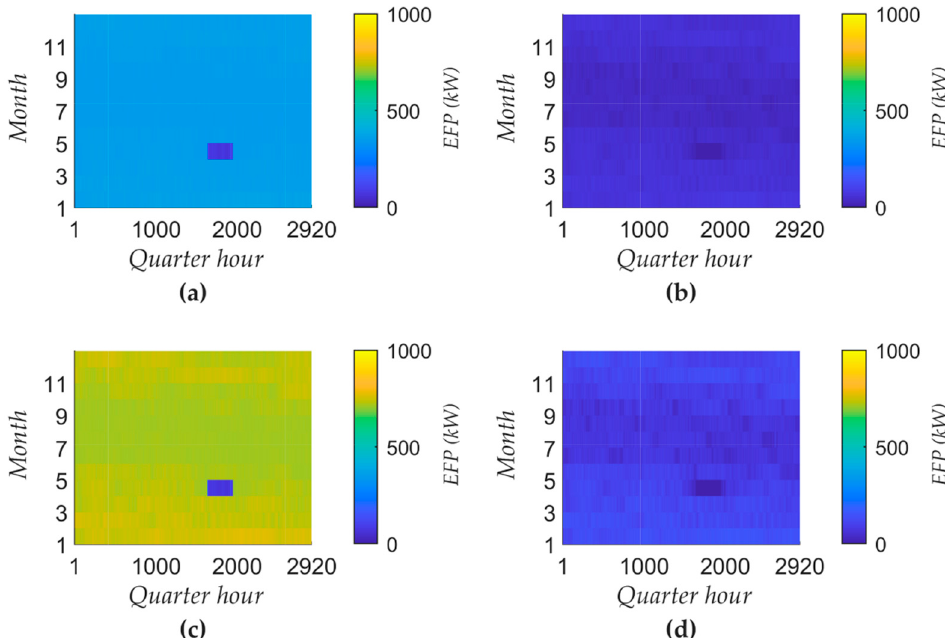
Figure 8. Technical energy-flexibility potential through storing energy inherently: ( a ) Primary balancing power of the evaporator; ( b ) Primary balancing power of the superheater; ( c ) Energy-flexibility potential for day-ahead marketing of the evaporator; ( d ) Energy-flexibility potential for day-ahead marketing of the superheater.